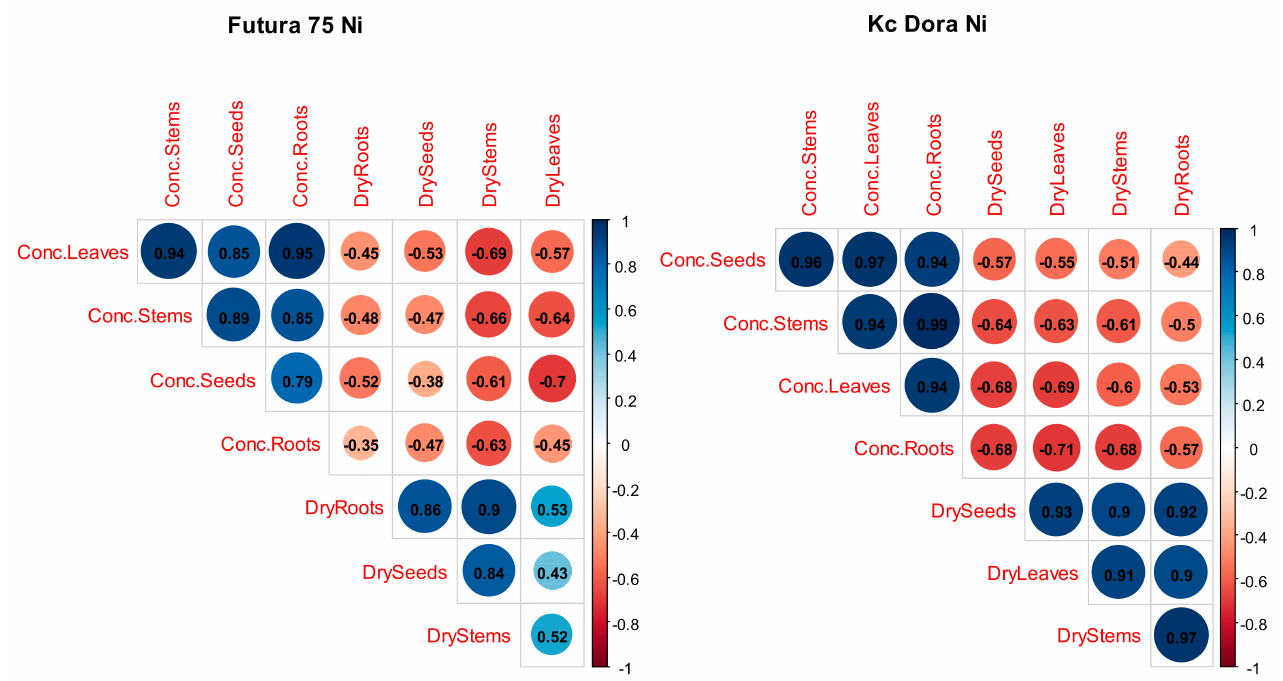
Figure 6. Correlation matrix of Ni of Futura 75 and KC Dora, using as the variable the biomass yield of roots, stems, leaves, and seeds, and the concentration of the heavy metal measured in each part of the plant. The numbers within the circles represent the Pearson correlation